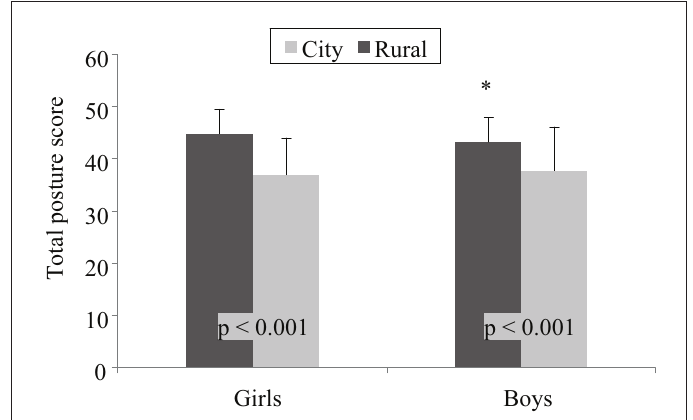
Note. * – p < 0.05 compared to total posture scores in rural girls and rural